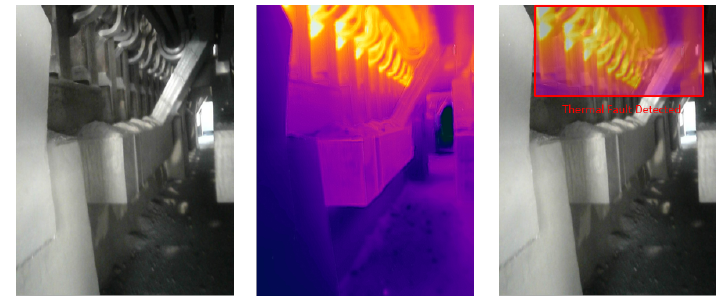
Figure 26. Thermal anomalies detection on-site for test run 4.